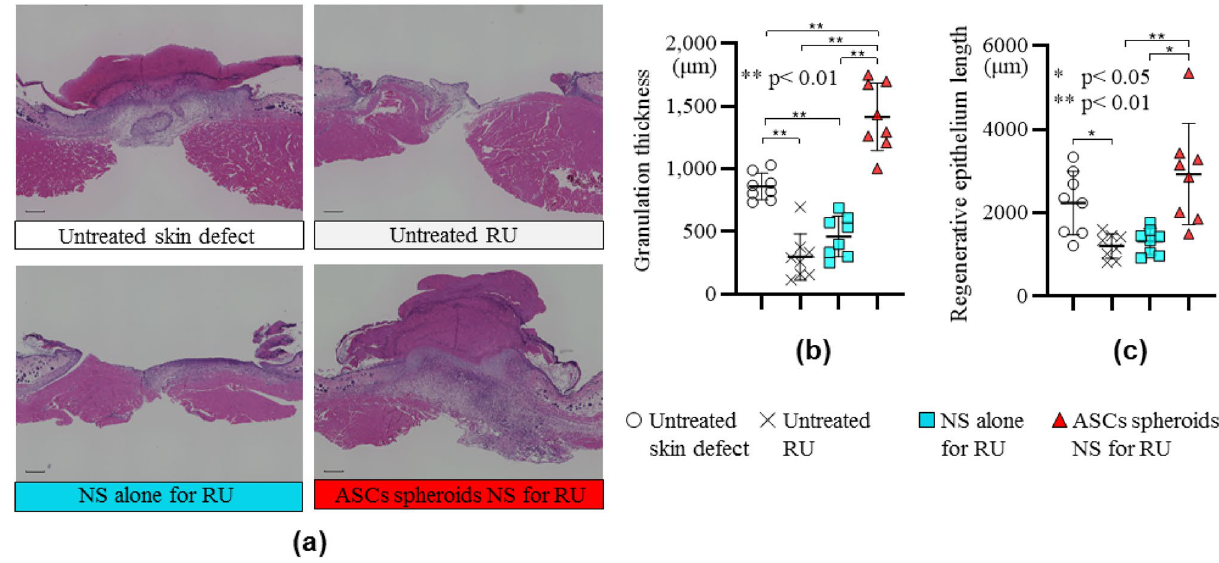
Figure 6. Histological evaluation of wound healing. ( a ) Pathological images of the wound on day 14 (HE stain, scale bar = 500 μm). ( b ) Thickness of formed granulation tissue in each treated group on day 14. The granulation tissue in the animal group of ASC spheroids NS for RU is about 4.8-times thicker than that in the Untreated RU group (granulation thickness: 1.41 ± 0.27 vs. 0.29 ± 0.18 mm, p < 0.01). ( c ) Length of regenerative epithelium in each treated group. The regenerative epithelium in the animal group of the ASC spheroids NS for RU is about 2-times longer than that in the Untreated RU group (regenerative epithelial length: 2.92 ± 1.21 mm vs. 1.12 ± 0.30 mm, p <